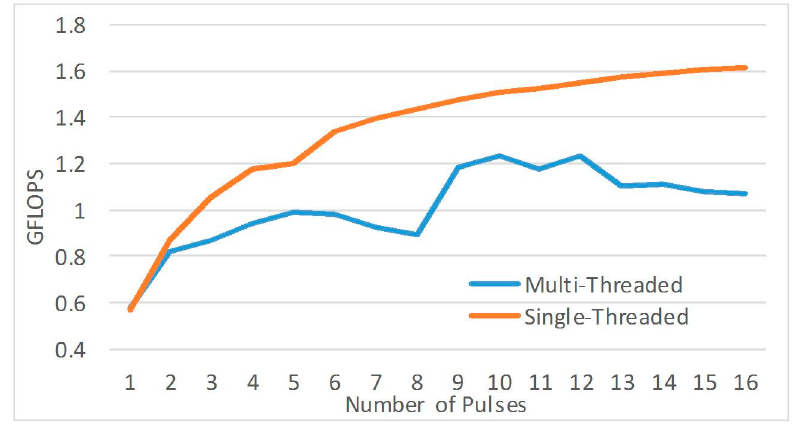
Figure 17. Pulse compression performance using OpenCL (8192 range gates).